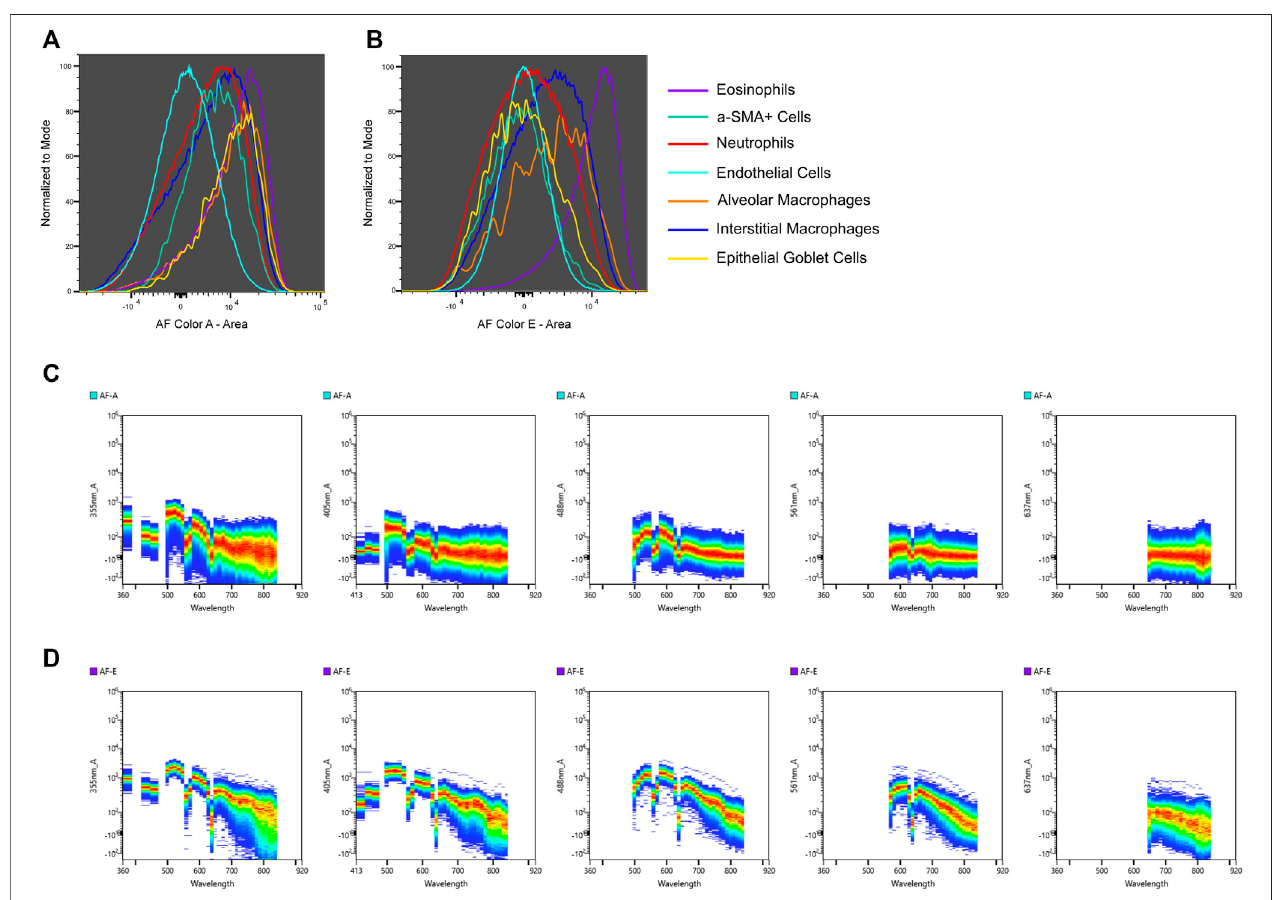
FIGURE 3 | AF signature tracing to a speci fi c cell type. The intensities of two unique AF signatures, AF color A (A) and AF color E (B) , are shown for cell types identi fi edbyimmunophenotyping.AFcolorEismoreintenseineosinophilscomparedtoothercelltypes.SpectralplotsoftheunstainedsampleforAFcolorA (C) andAF colorE (D) areshowntocompareinwhichregionsofthespectrumtheseAFsignaturesemit[wavelength( x -axis)isinnm].AFcolorEhasadistinctemissionintheyellow- green region of the spectrum (500 – 550 nm) which is indicative of fl avins. The intense presence of AF color E in eosinophils and AF color E having emission in the spectral region of fl avins links AF color E to